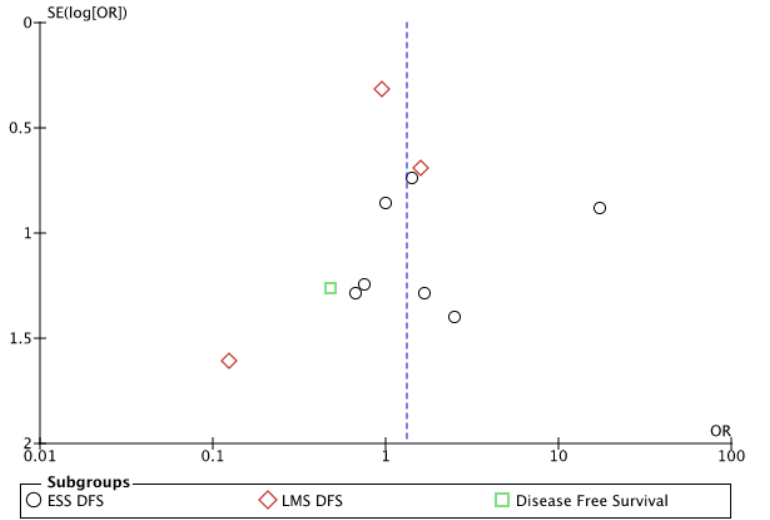
Figure A2. Diseas-Free Survival Funnel Figure B2. Diseas-Free Survival Funnel Plot.